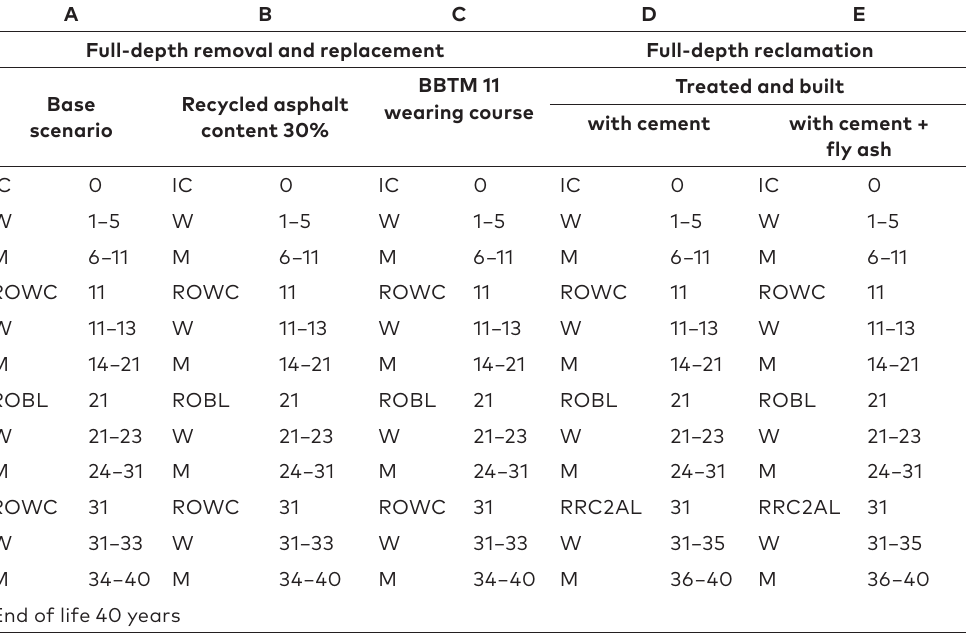
Table 6. Maintenance and rehabilitation plan of various